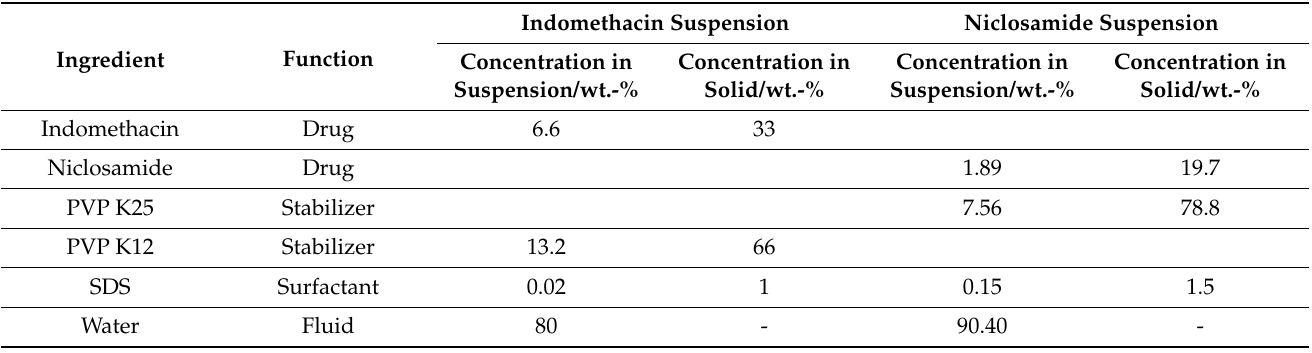
Table 2. Composition of Indomethacin and Niclosamide